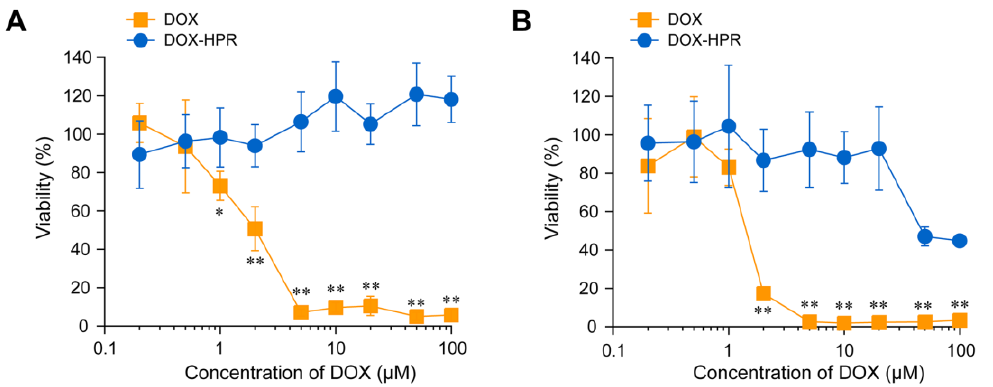
Figure 6. ( A ) Viability of colon-26 cells treated with DOX and DOX-HPR for ( A ) 24 h and ( B ) 48 h. Data are expressed as mean ± standard deviation (n = 6). * p < 0.05, ** p < 0.0001 vs. untreated cells (100% cell viability).